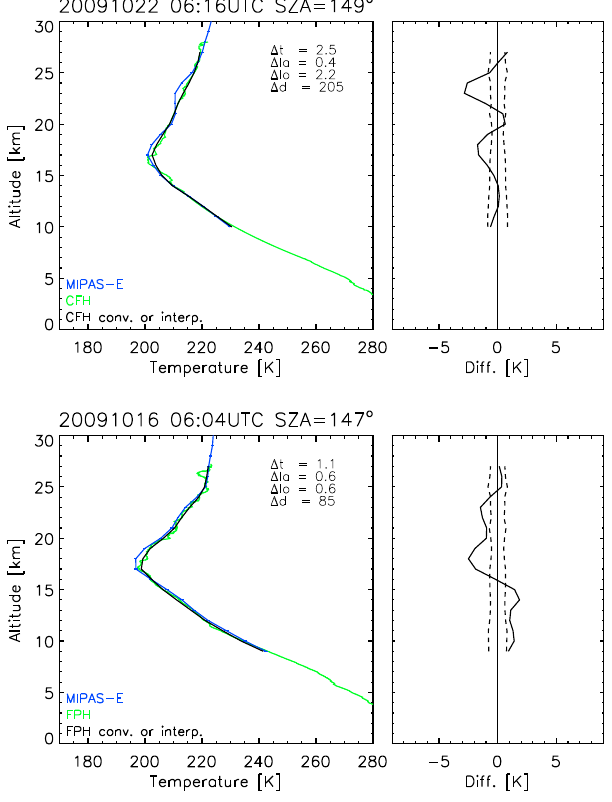
Fig. 3. Same as Fig. 1 but for RS92 radiosonde temperature profiles recorded during flights with the CFH (top) and NOAA FPH (bot- tom) frost point hygrometers. For a more detailed description see Fig. 1.